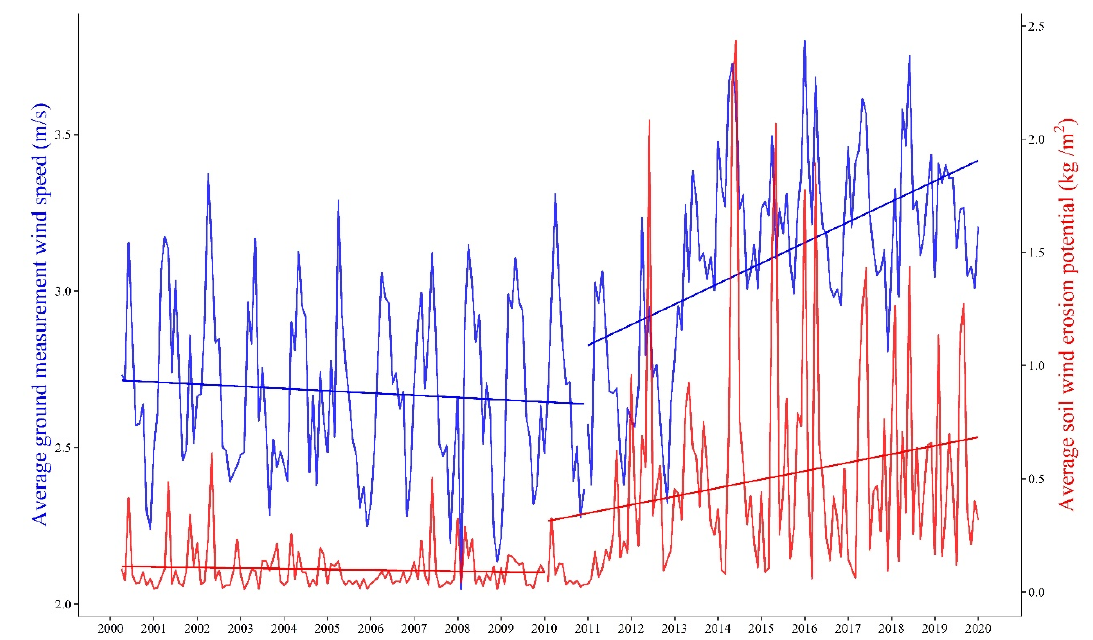
Figure 8. Average GMWS and average SWEP across CA from 2000 to 2019.